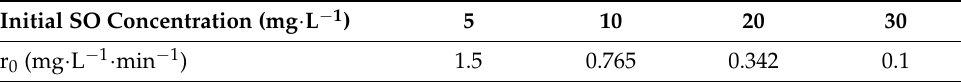
Figure 3. Effect of initial substrate concentration on SO degradation by UV/TiO 2 /IO 3 − process ([IO 3 − ] = 0.15 mM, [TiO 2 ] = 0.4 g · L − 1 , [SO] = 10–30 mg · L − 1 , T = 25 ± 2 ◦ C and pH~6). Table 1. Dependence of initial degradation rate on SO initial concentration in the range (5–30 mg · L − 1 ) through UV/TiO 2 /IO 3 − process.